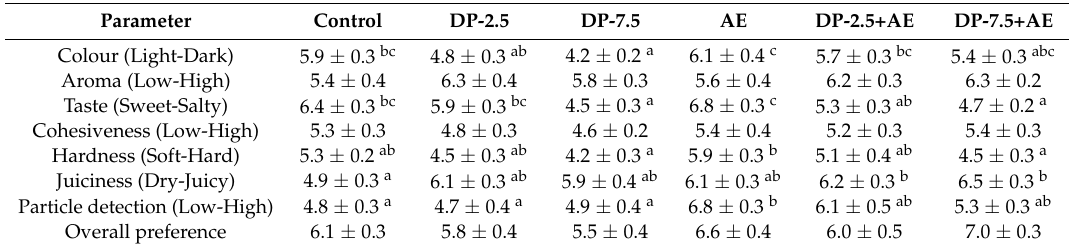
Table 4. Sensory evaluation of the different p â t é s with date paste (DP) (0%, 2.5% and 7%) and annatto extract (AE) (0 and 128 mg/kg) (Mean ±